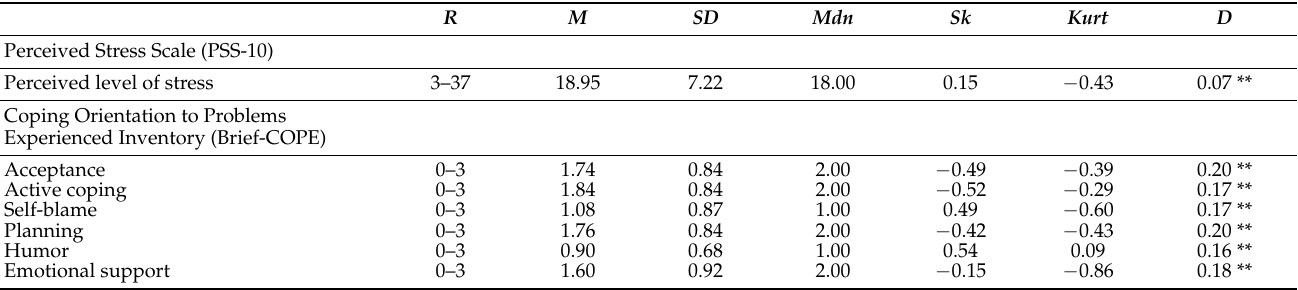
Table 2. Perceived stress and coping